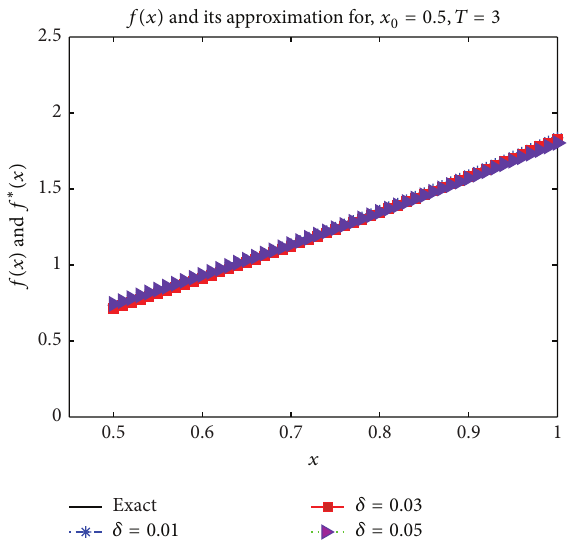
Figure 3: The exact 𝑓 and its approximation 𝑓 ∗ obtained with 𝑁 = = 0.5 and for various levels of noise 20 , 𝑇 = 3 , 𝛿 = 0.01 , and 𝑥 0 added into the data using MQ-RBF with 𝑐 = 0.1 .